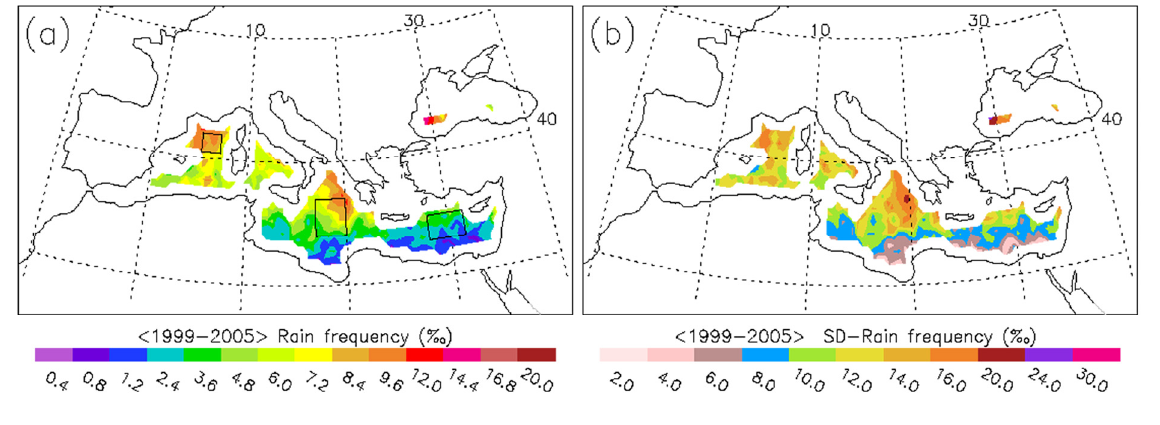
Figure 8. ( a ) HOAPS-3.2 rain-frequency climatology (‰) and ( b ) interannual